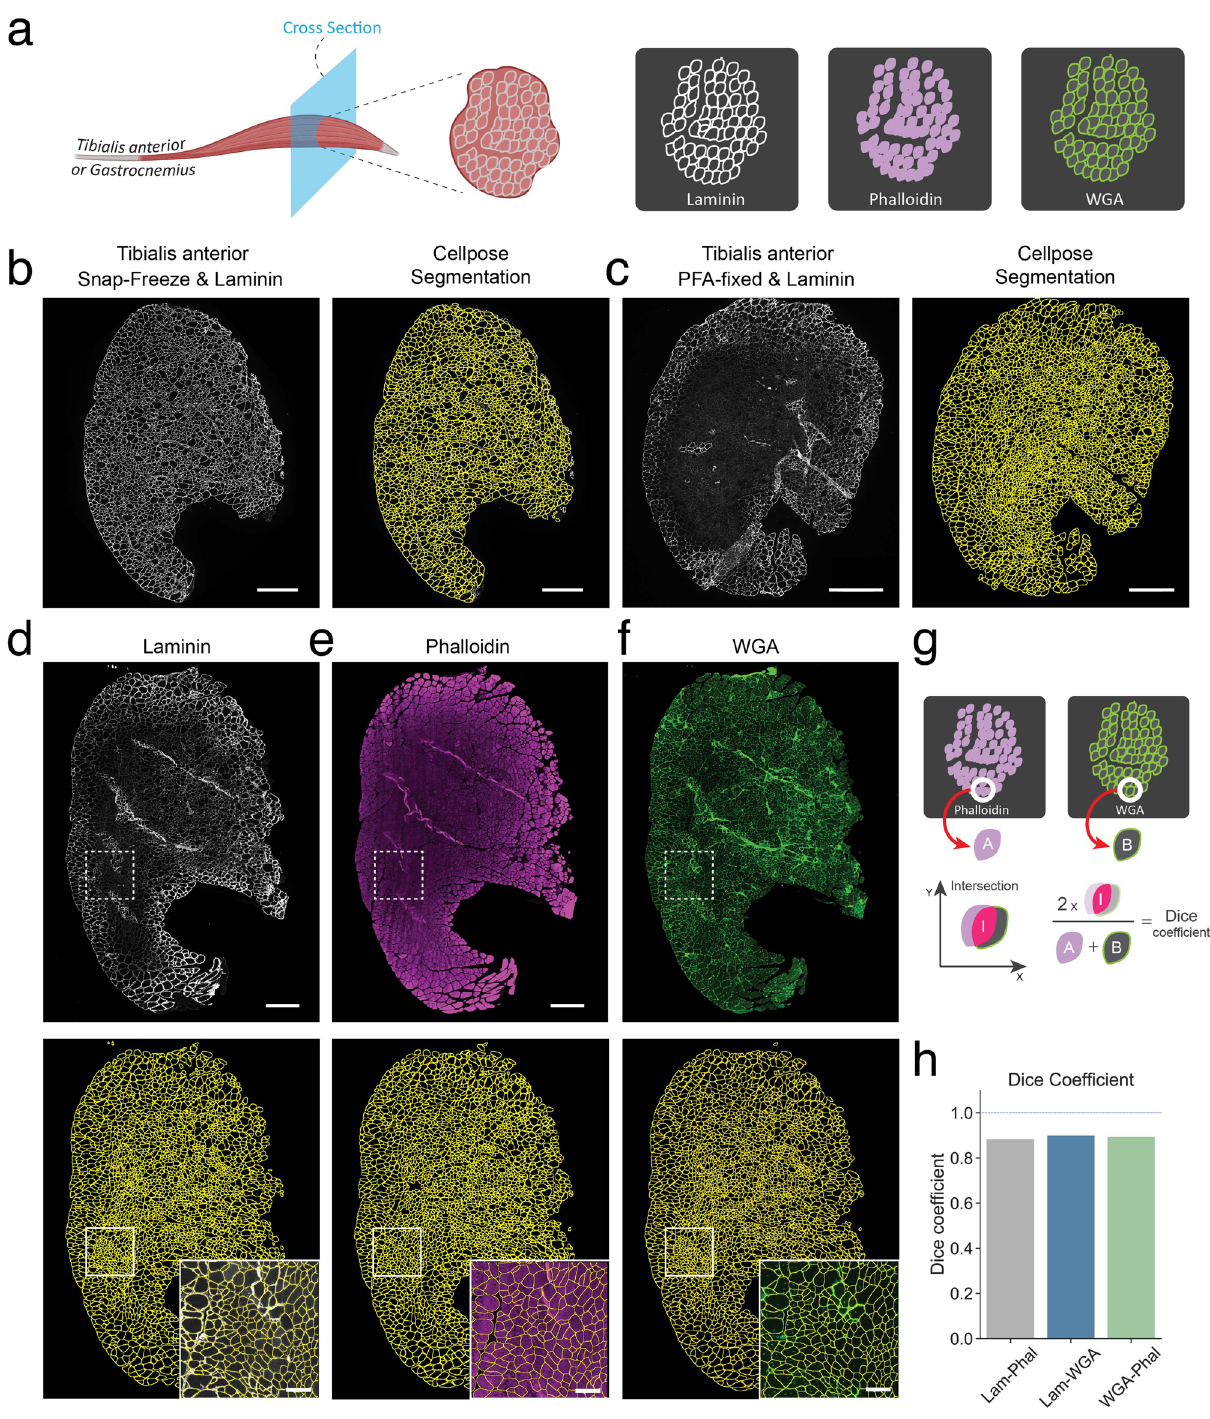
Figure 2. Myofiber segmentation using Cellpose. ( a ) Schematic of the experimental design. ( b ) Cross section of a snap-frozen tibialis anterior muscle stained for Laminin. Right, original image. Left, Cellpose segmentation results. Scale bar, 500 μm. ( c ) Cross section of a PFA-fixed tibialis anterior muscle stained for Laminin. Right, original image. Left, Cellpose segmentation results. Scale bar, 500 μm. ( d-f ) Cross section of a PFA-fixed tibialis anterior muscle stained for Laminin ( d ), Phalloidin ( e ) and WGA ( f ). Top, original images. Bottom, result of Cellpose segmentation. Inset, detail of the specified region. Scale bar within inset, 500 μm. ( g ) Diagram depicting the calculation of the Dice coefficient. For each segmented object in the two label images, the Dice coefficient is the result of two times the area of the intersection divided by the sum of the areas of both objects. ( h ) Mean Dice coefficient for all myofibers in the comparison between the indicated